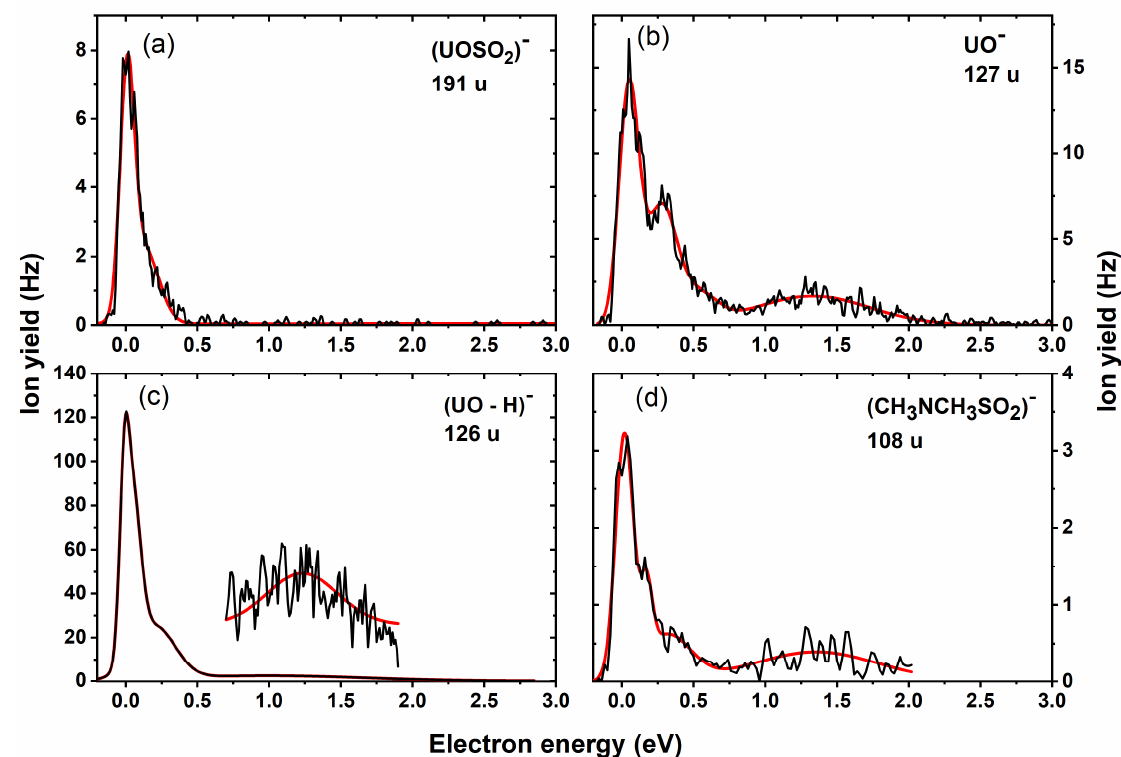
Figure 2. Anion efficiency curve for the fragment anions ( a ) UOSO 2− , ( b ) (UO) − , ( c ) (UO-H) − and ( d ) ((CH 3 ) 2 NSO 2 ) − formed upon dissociative electron attachment (DEA) to DMSU.